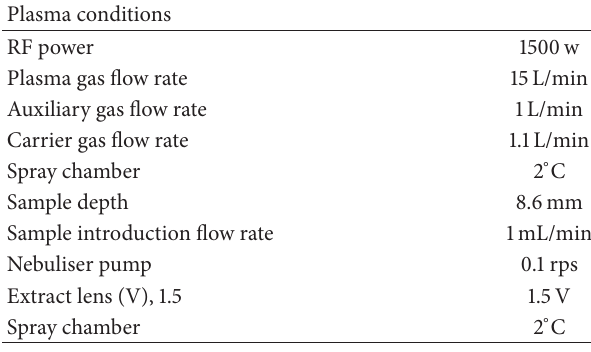
Table 2: Work specification resume for ICP-MS.